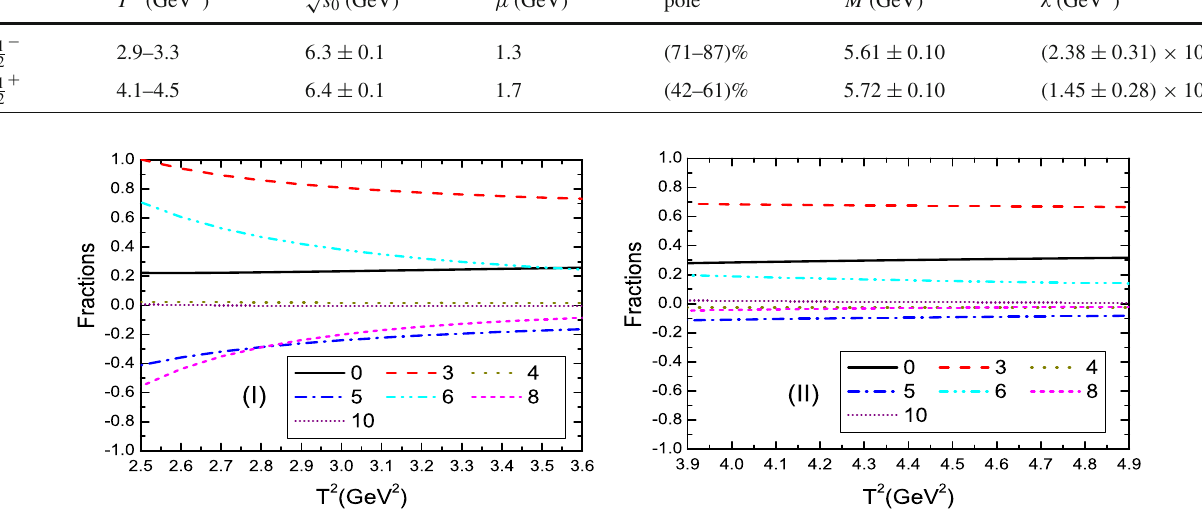
Fig. 1 The contributions of the vacuum condensations of dimension n with n = 0, 3, 4, 5, 6, 8 and 10, where the (I) and (II) denote the negative parity and positive parity pentaquark states,